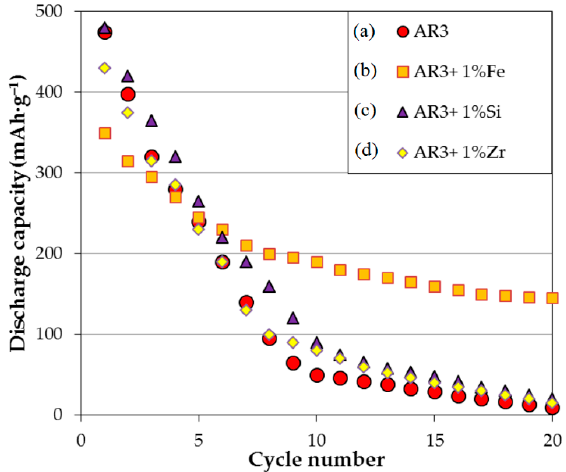
Figure 6. Cycling performances of MS + MA AR3 powders with ( a ) no additive; ( b ) 1 wt% Fe; ( c ) 1 wt% Si; and ( d ) 1 wt% Zr MA for 3 h with 100 mA·g − 1 charge and discharge current densities. Cycle